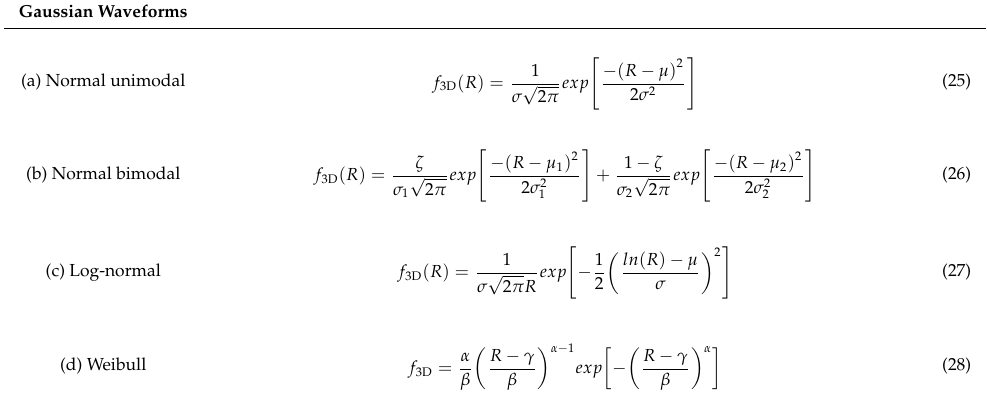
Table 1. This table lists the Gaussian waveforms used to assess the 3D → 2D conversion functions. Gaussian